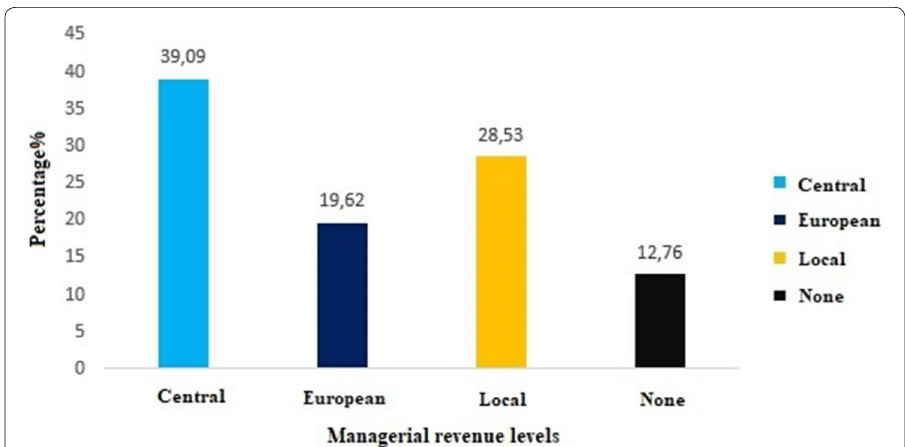
Fig. 7 State revenue management at three levels including European